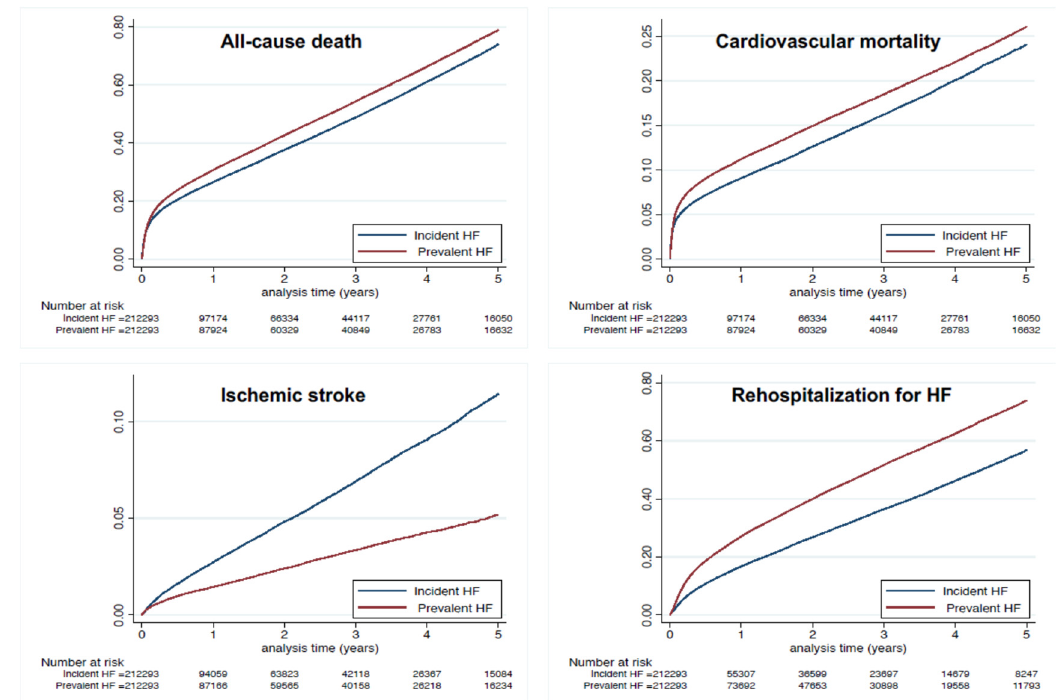
Figure 4. Cumulative incidences for all-cause death ( top left panel ), cardiovascular death ( top right panel ) and ischemic stroke ( lower left panel ) and re-hospitalization for HF ( lower right panel ) in the matched cohort of patients with AF and HF, with incident HF and prevalent HF.